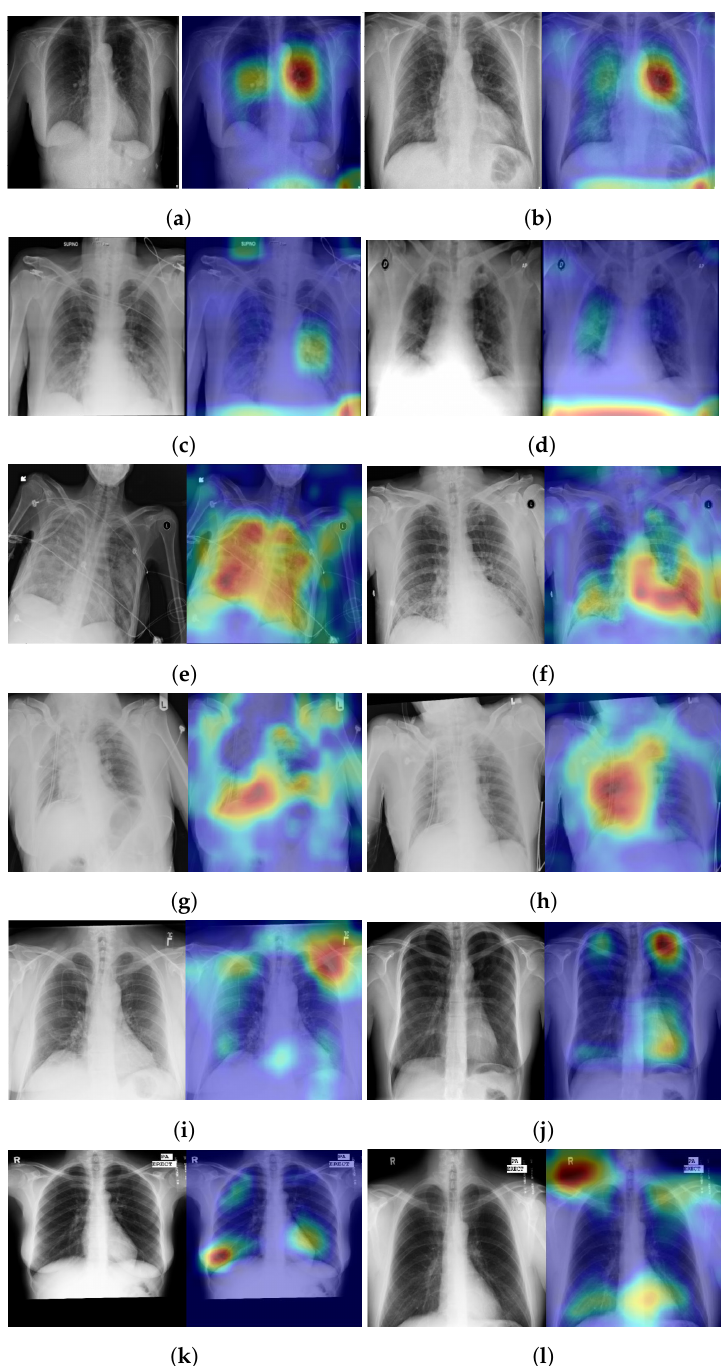
Figure 20. Explainabilty of TP and TN cases. The heatmap highlights important areas detected by our deep learning model in the CXR images: ( a , b ) CIDC; ( c , d ) COVID-19 RADIOGRAPHY; ( e , f ) RSNA; ( g , h ) NIH; ( i , j ) CIDC; ( k , l )